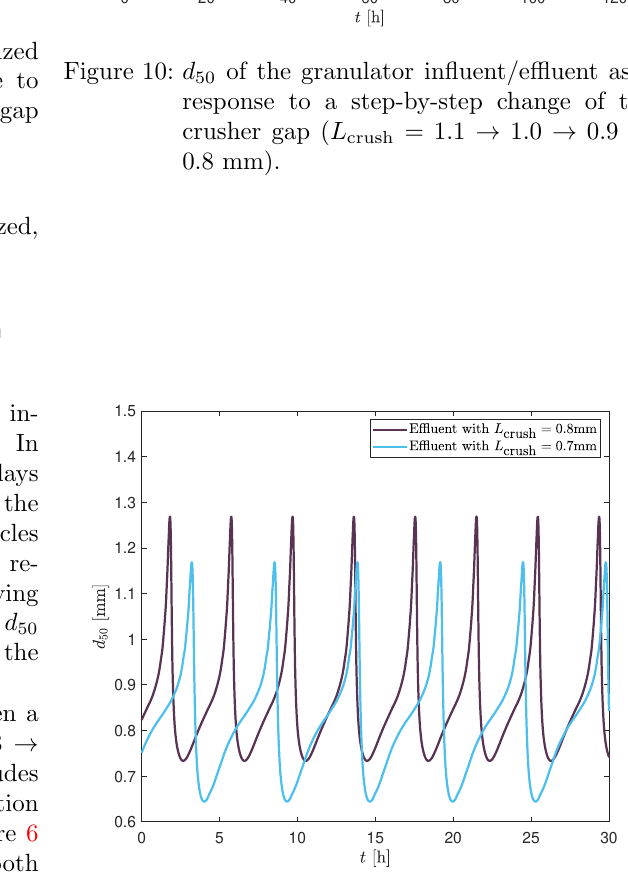
Figure 11: Sustained oscillations at L crush = 0 . 8 mm versus at L crush = 0 . 7